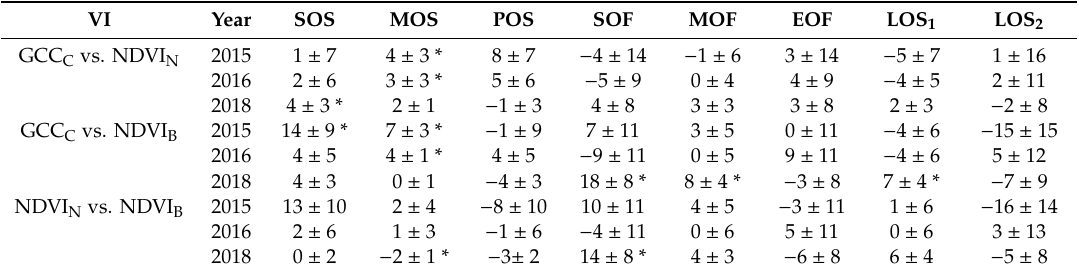
Table 6. Di ff erences (number of days, mean ± 95% confidence interval) in phenophases between di ff erent